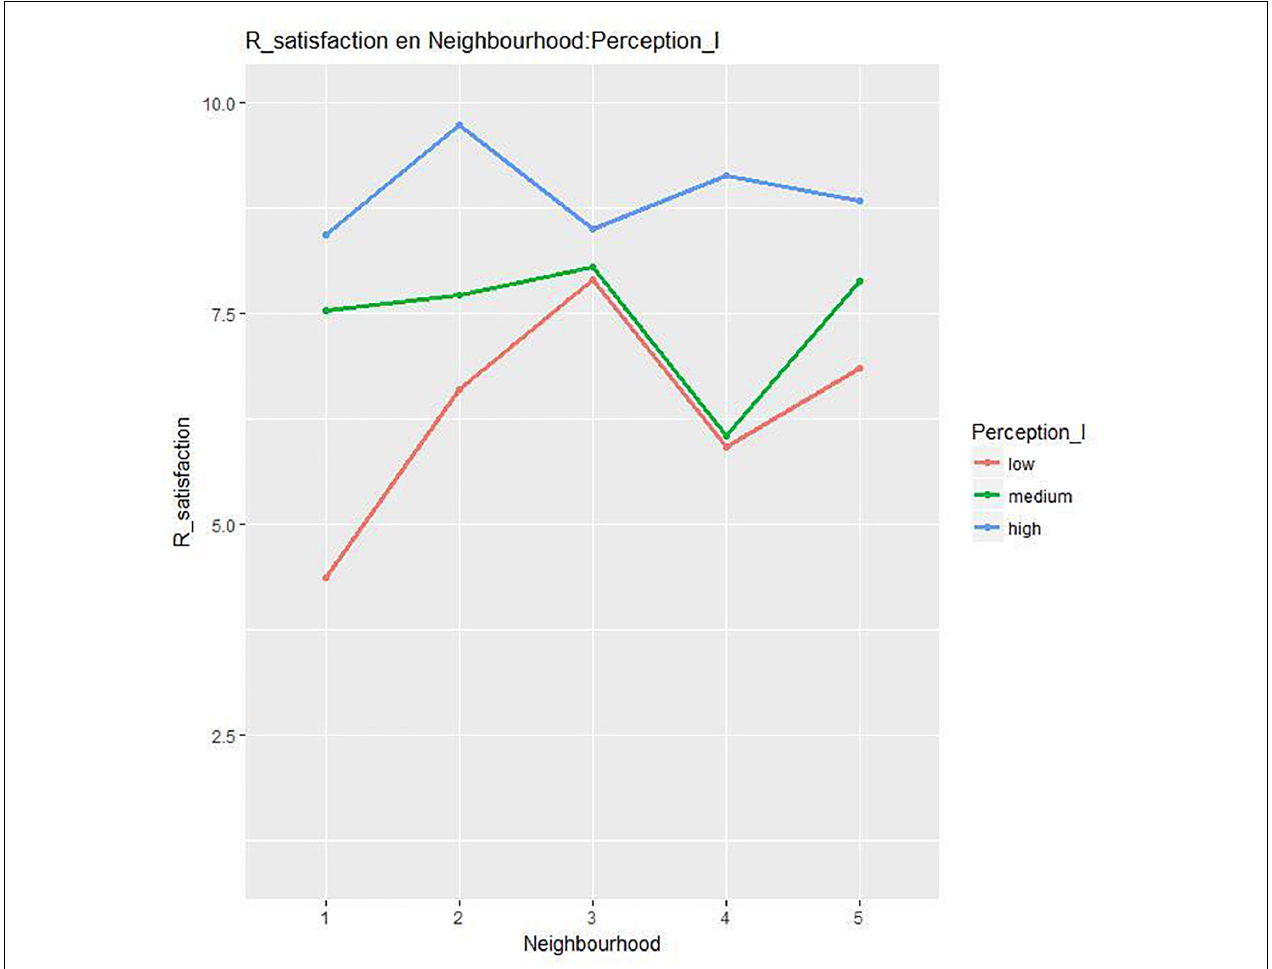
FIGURE 3 | Differences in residential satisfaction by Neighborhood ∗ Levels of Perception